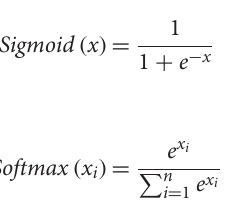
FIGURE 3 | The serum level of IgG N-glycopeptides in the migraine ( n = 20) and healthy control groups ( n = 20). The level of IgG N-glycopeptides was presented as box plots showing median values, upper and lower quartiles, as well as the whole range for patients and controls. The glycan species were named as G0, G1, and G2 according to the numbers of galactoses, F, fucose; N, N-acetylglucosamine. * p <